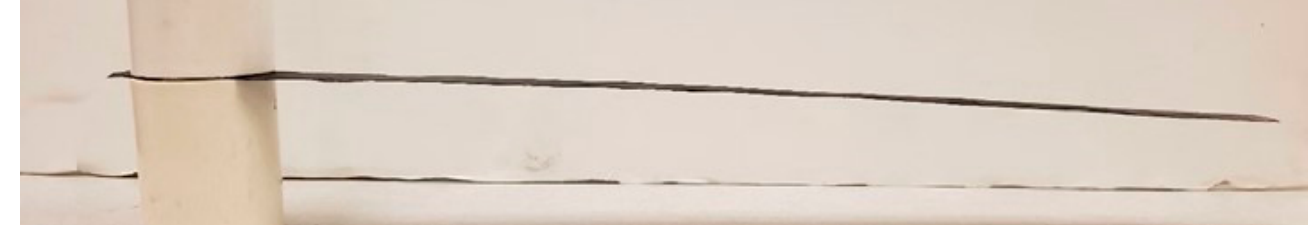
Figure 13. CFRP-CNT strip (cantilevered, with thin polymer binder). The material is lower density than CFRP, more flexible, and is expected to have lower strength in compression than CFRP.